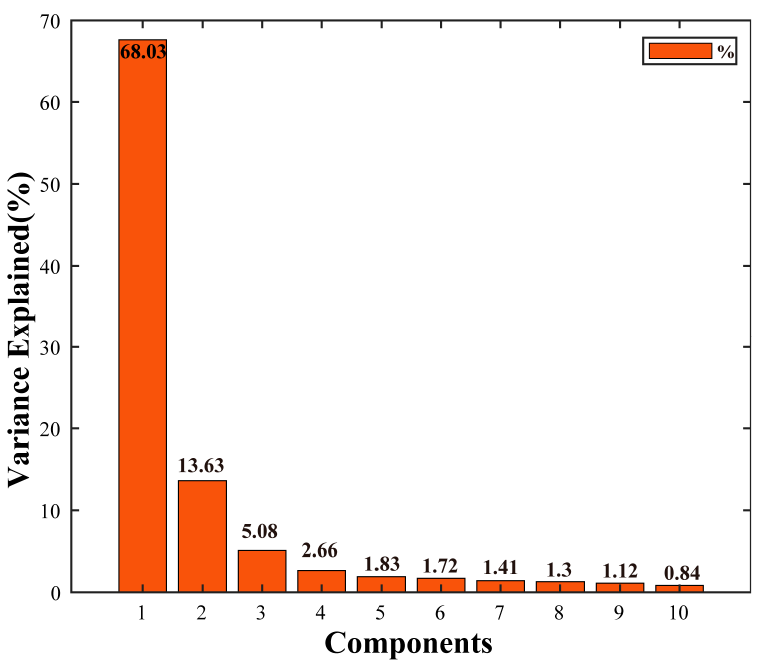
Figure 6. Percentage of variance explained in the first 10 components of the PCA used to choose the number of components for ICA.